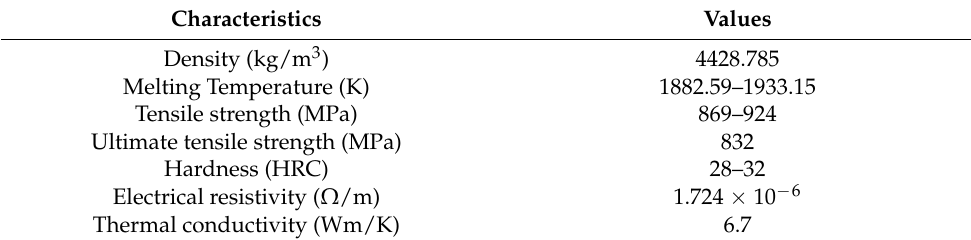
Table 2. Nominal properties of Ti-6Al-4V workpiece (taken from